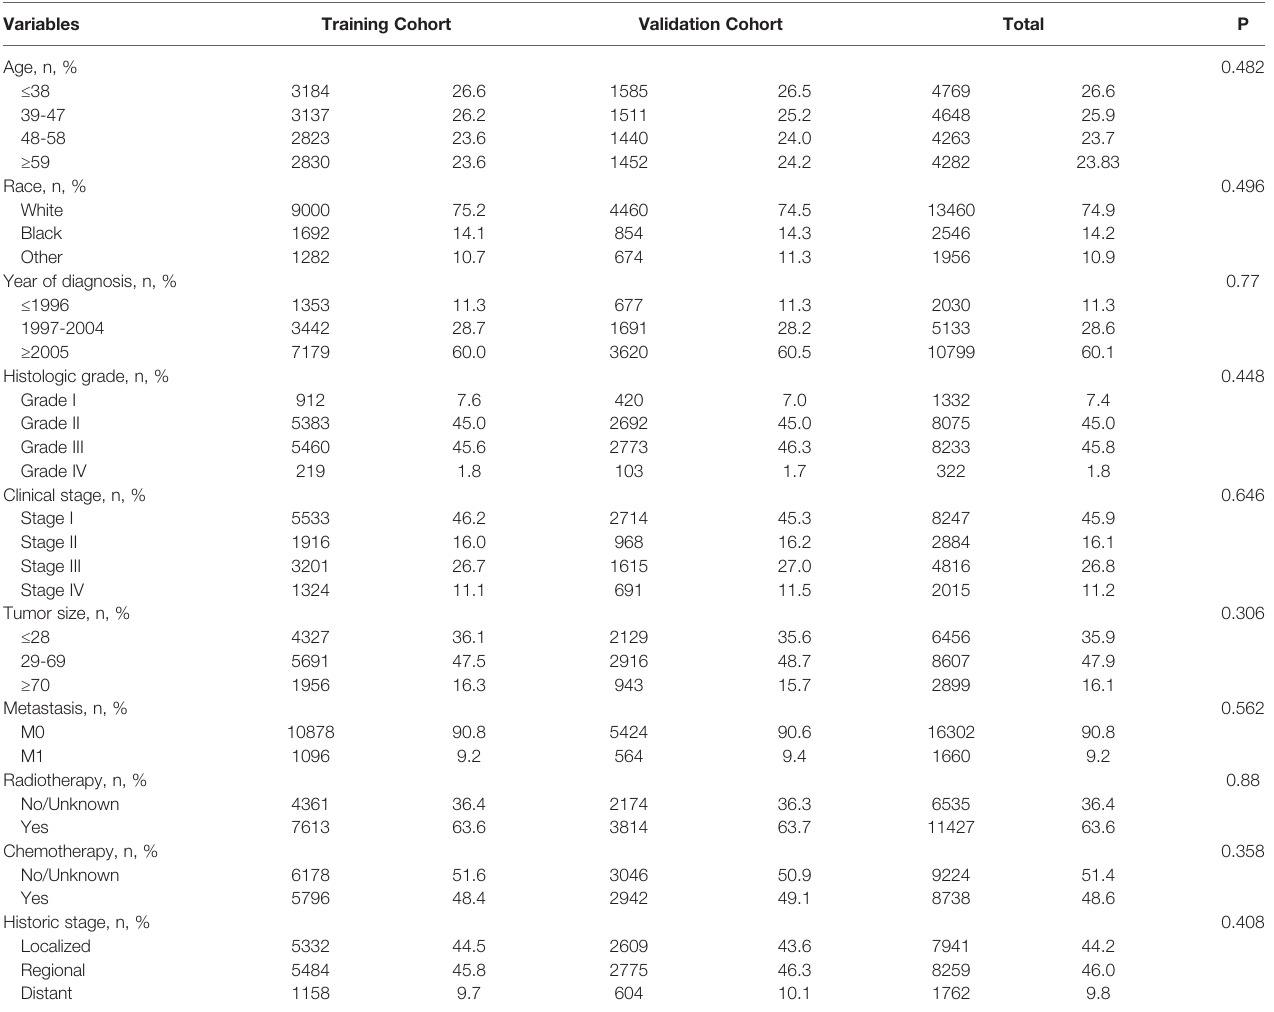
TABLE 1 | Baseline characteristics of patients with cervical squamous cell carcinoma in the training cohort and validation cohort. Variables Training Cohort Validation